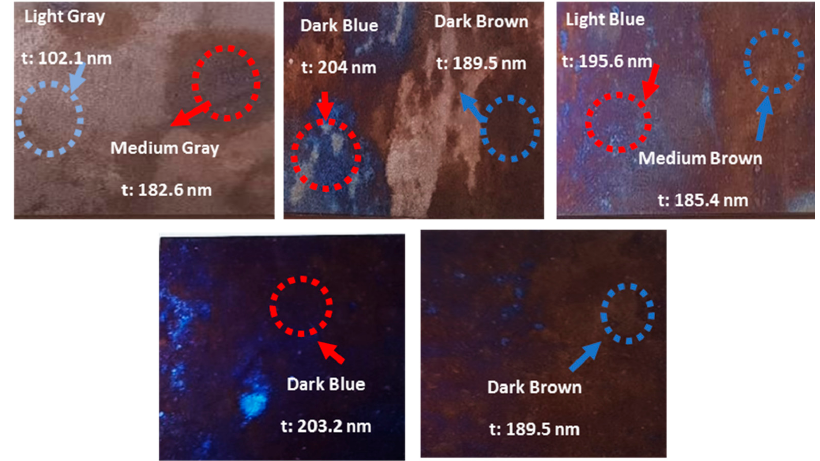
Figure 1. Color changing due to the formation of oxide films with a variety of thicknesses ( t ) in different parts of a titanium sheet used as exterior cladding of a building located in Taiwan.